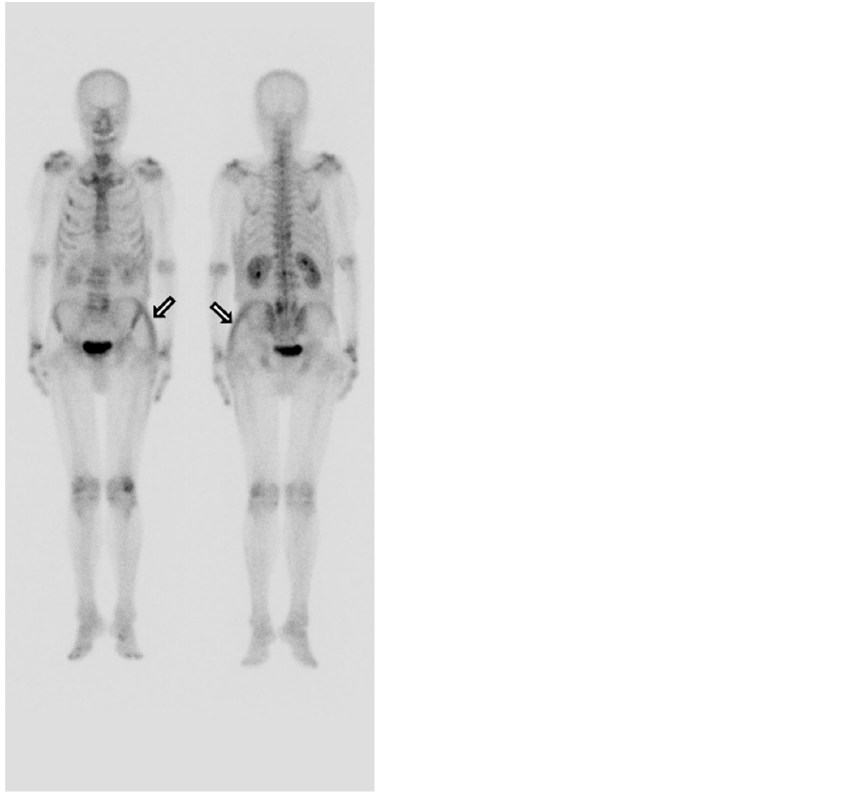
Figure 3. Technetium-99m methylene diphosphonate (MDP) whole-body bone scan shows a curvilinear-shaped hyperactive lesion in the left buttock and left flank and no other fracture site.